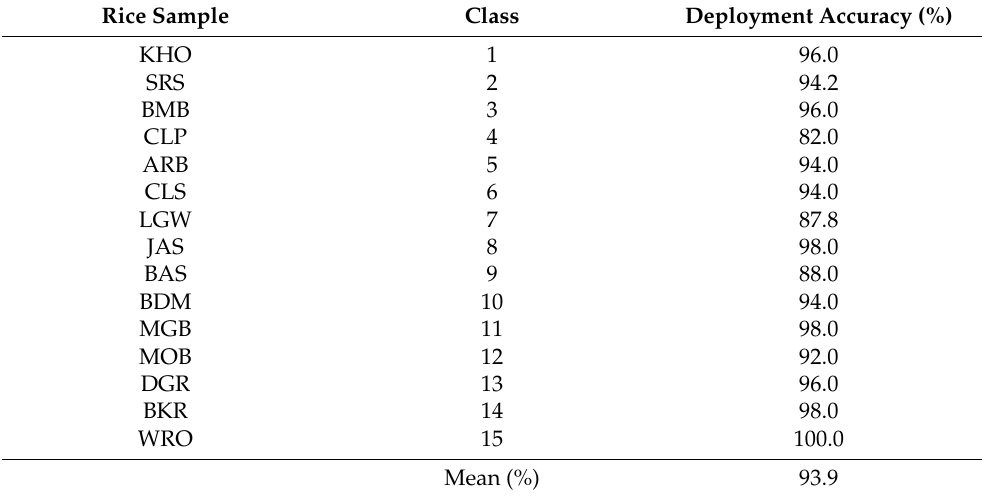
Table 5. Results of deployment accuracy when tested on the new data set obtained from 2D Photo- Bench 120 lightbox. The abbreviations for the rice samples are shown in Table 1.